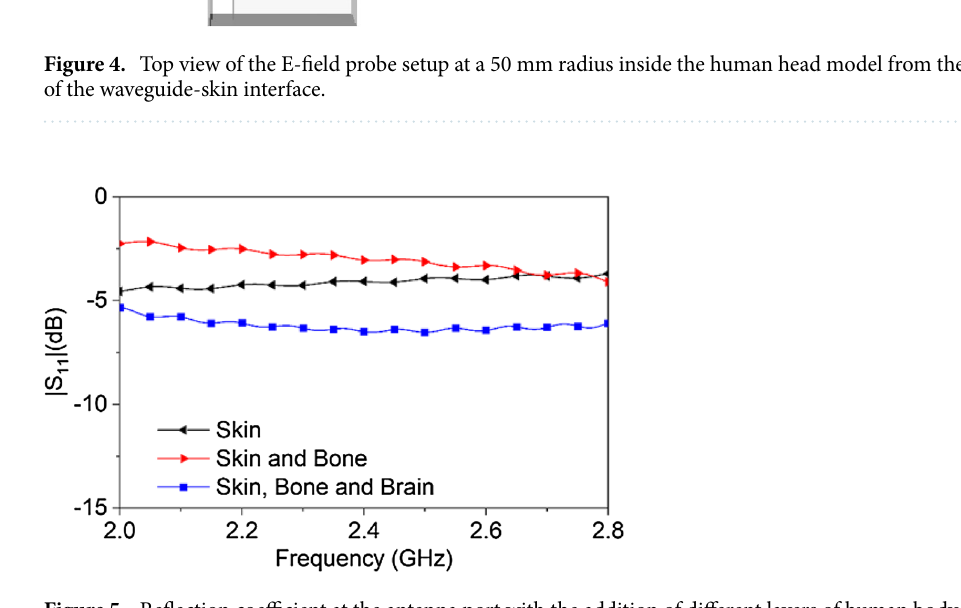
Figure 5. Reflection coefficient at the antenna port with the addition of different layers of human body phantom materials at the opening of the dielectric loaded rectangular waveguide.